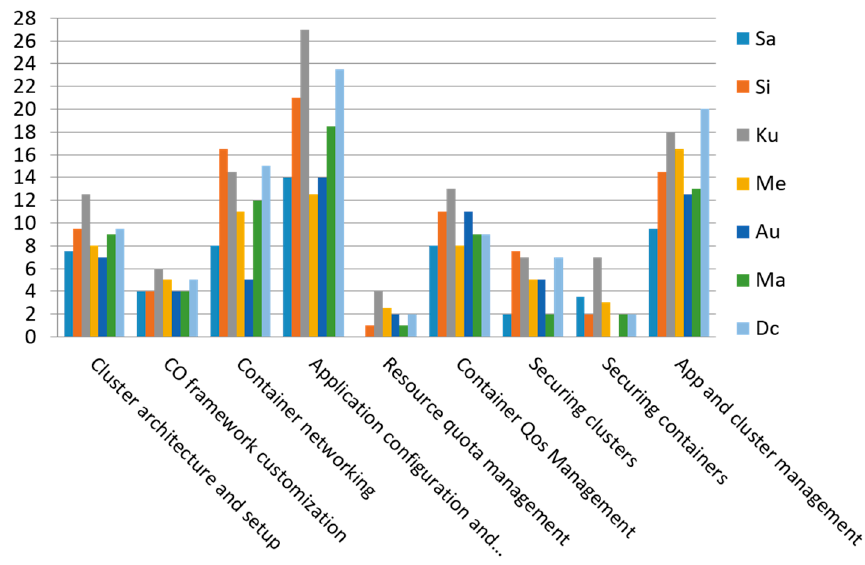
Figure 6. The number of common feature implementation strategies supported by each CO framework is shown for each of the 7 CO frameworks.